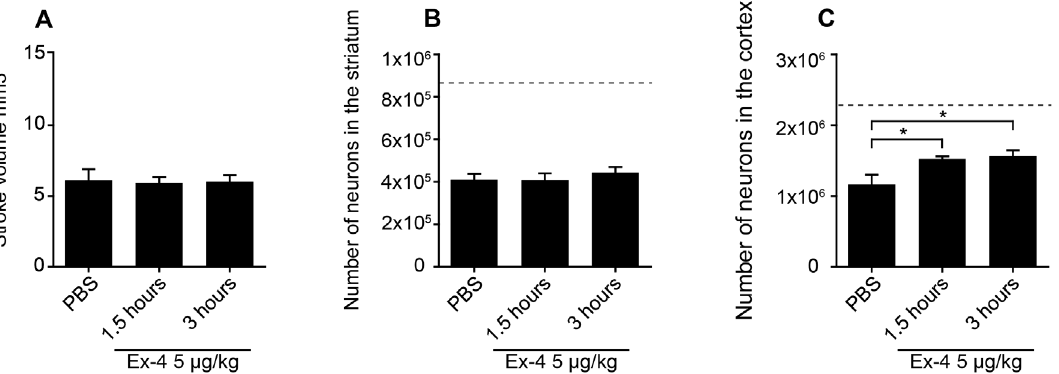
Figure 3. Neuroprotective effects of Ex-4 in aged, diabetic/obese mice (Study 3). Stroke volume at one week after 50 m g/kg (A) Ex-4 administration. Number of surviving neurons in the striatum (B) and cortex (C) at one week after 50 m g/kg Ex-4 administration at 1.5 and 3 hours after MCAO. The dashed lines on B and C indicate the number of neurons in the contralateral corresponding intact brain areas. Data are presented as means 6 SEM. * denotes p , 0.05.